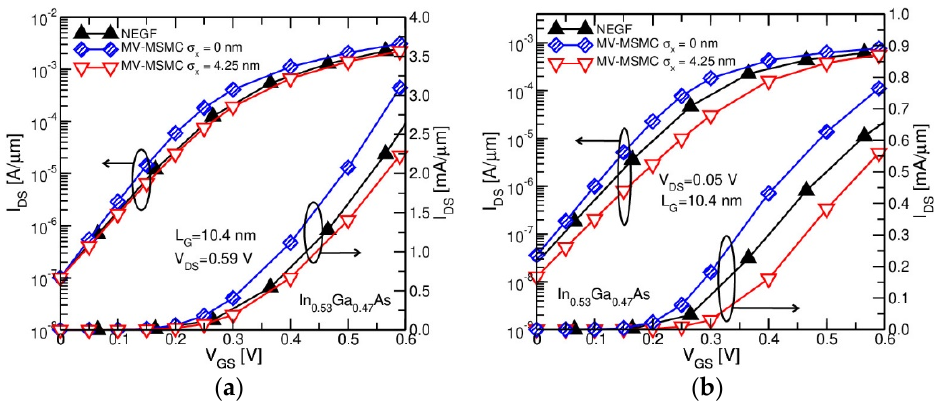
Figure 6. Same as Figure 4 for an InGaAs n-MOSFET with L G of 10.4 nm. V DS is 0.59 V for ( a ) and 50 mV for ( b ).